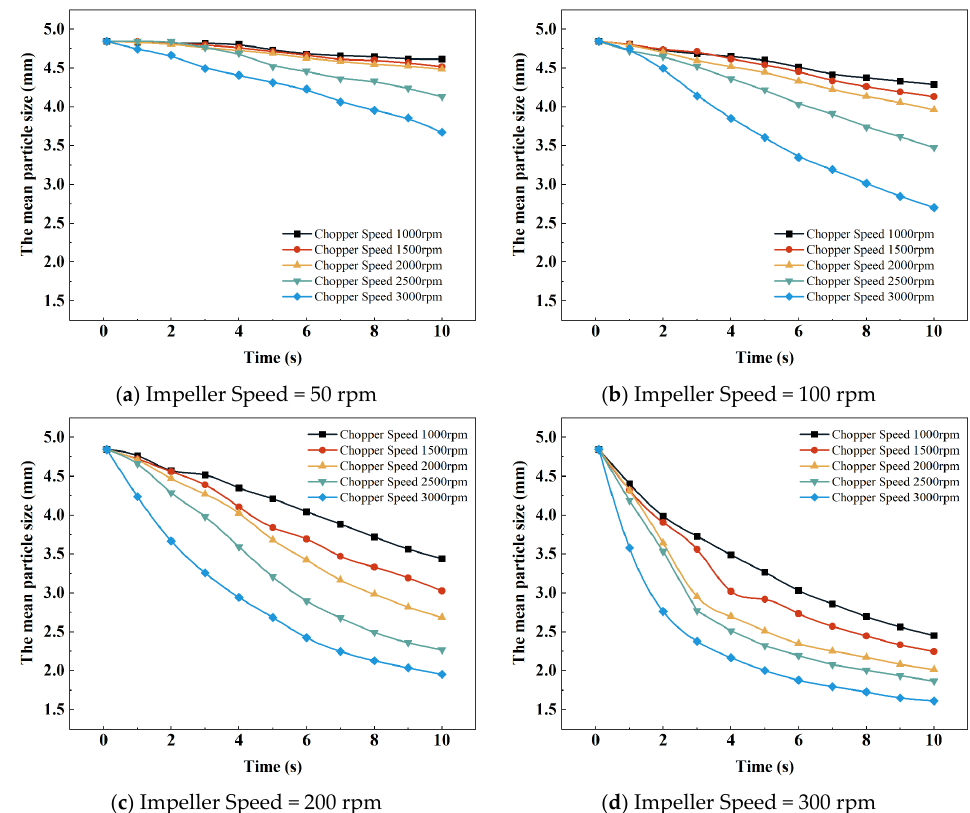
Figure 14. The variation in mean particle size with impeller speed.